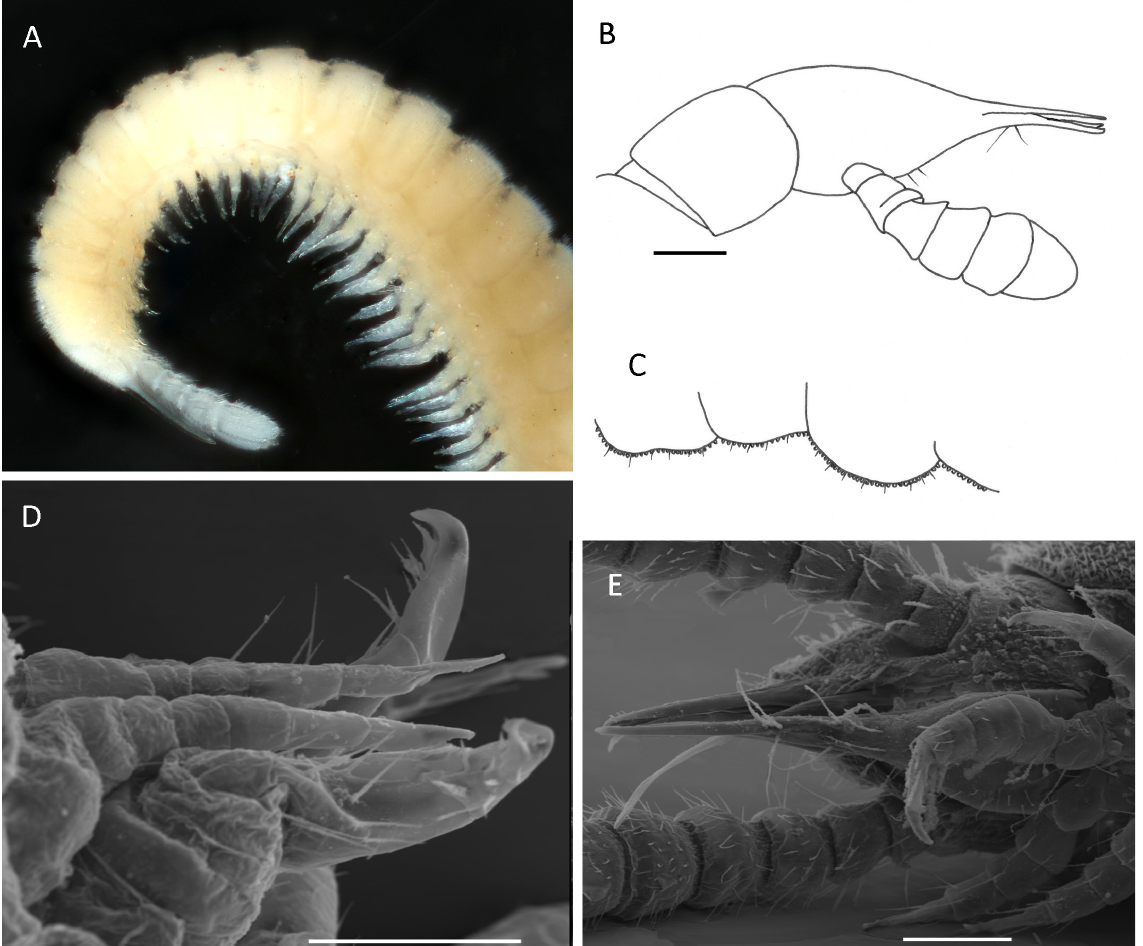
Fig. 7. Siphonophora tuberculata sp. nov., paratype. A . Head and anterior rings, body width approximately 0.5 mm. B . Holotype, head in lateral view. C . Holotype, mid-body pleurites in lateral view. D . Gonopods in situ. E . Head in ventro-lateral view with mandible visible. Scale bars: B–C = 200 µm; D–E = 100